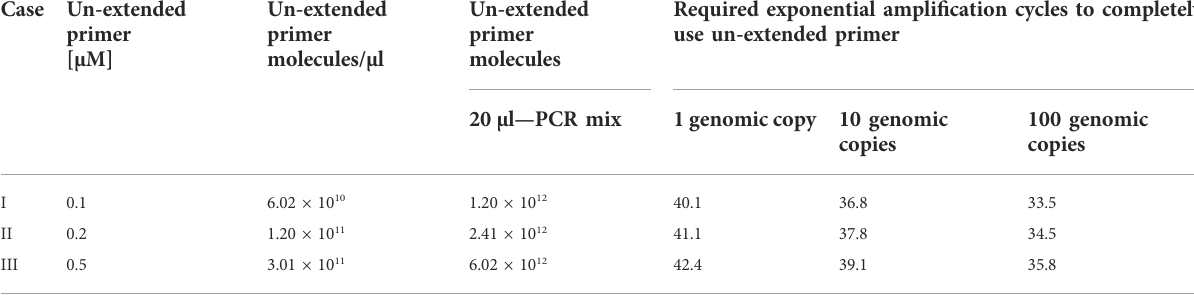
TABLE 2 A model to calculate the required amount of un-extended primer molecules and ampli fi cation cycles to amplify varied concentrations of initial template in an asymmetric PCR. Case Un-extended